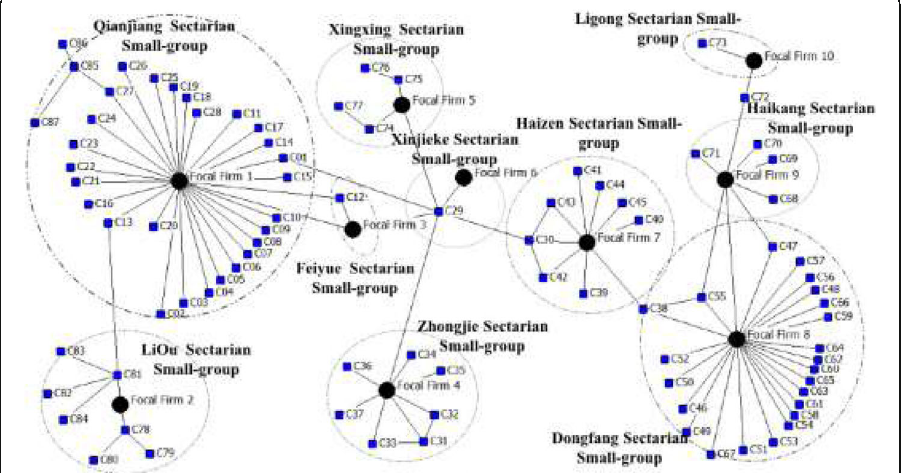
Fig. 3 Schematic diagram of branches of a Taizhou open financing trust network in